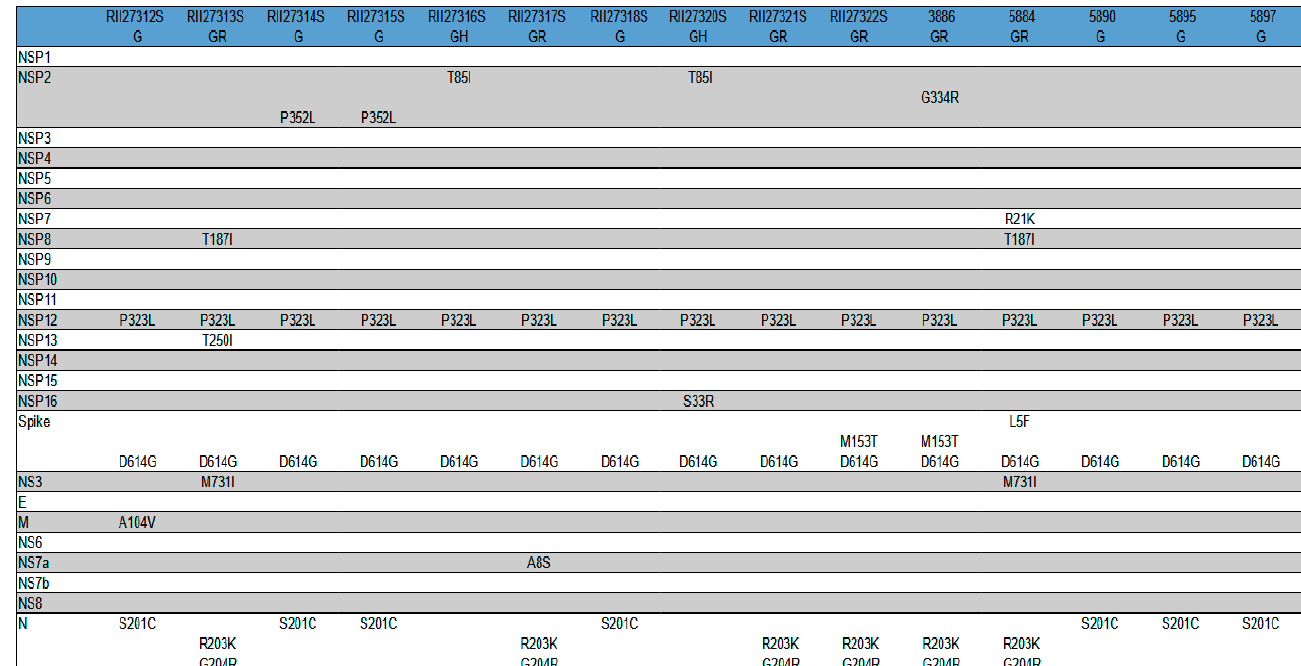
Figure 5. The heat map of the genetic distances between the genomes of SARS-CoV-2 isolates from Novosibirsk. The color gradient from green to red corresponds to an increase in pairwise genetic distances.